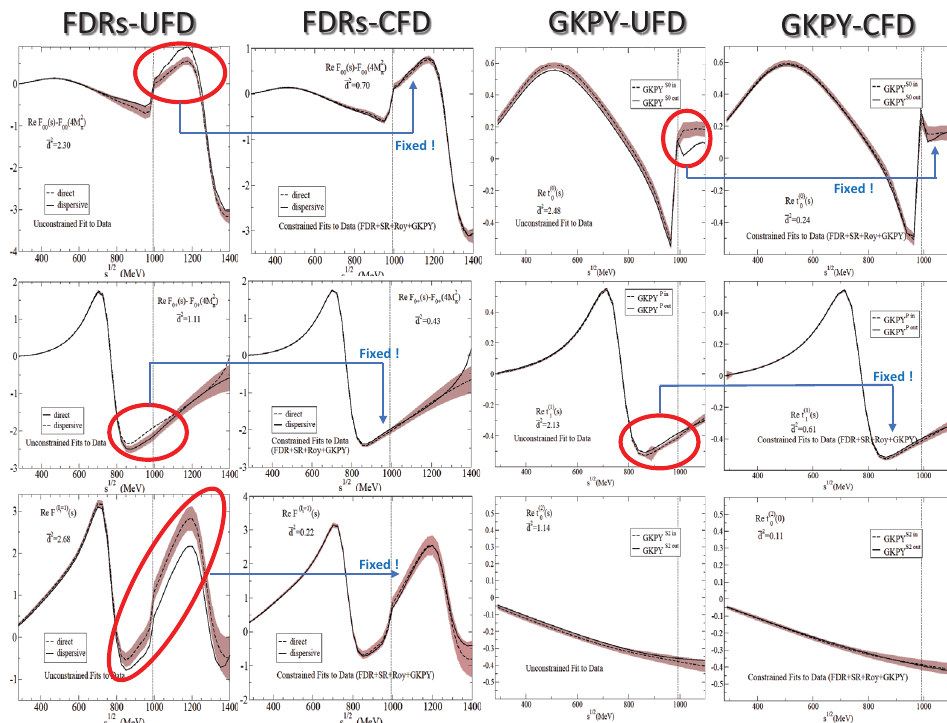
Figure 6. Unconstrained fits to data (UFD) do not satisfy well dispersion relations, as seen in column one for FDRs and column 3 for GKPY equations, particularly in the regions highlighted by red ellipses. This is fixed by the Constrained fits to data CFD in columns two (FDRs) and four